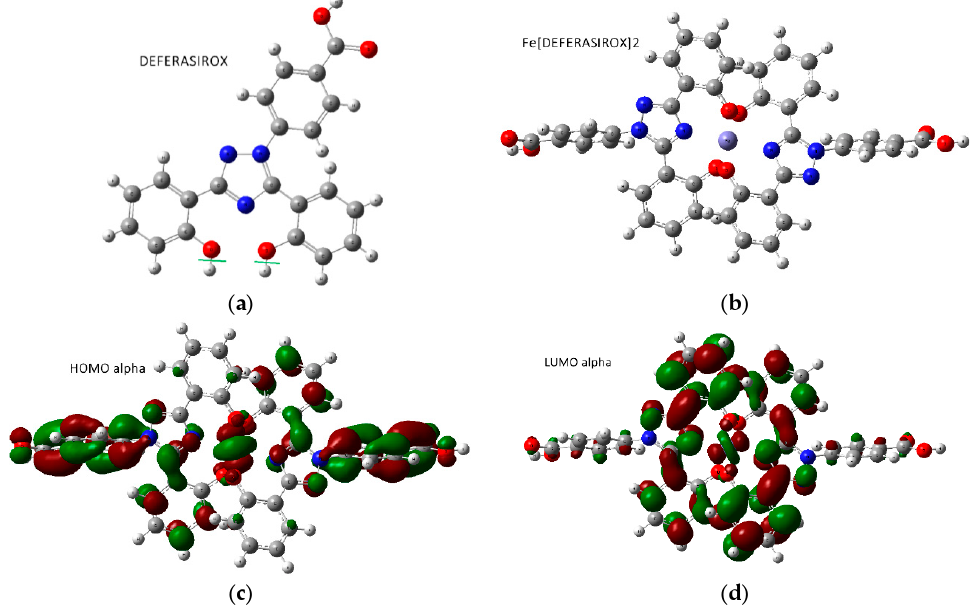
Figure 1. Deferasirox as an iron chelator for therapeutic applications. ( a ) Single molecule with the chelating centers created by removing two hydroxyl H as shown with green lines; ( b ) two molecules needed to chelate the iron(III) ion (Fe 3+ ) within an octahedral coordination; ( c , d ) frontier molecular orbitals (FMOs)—highest occupied molecular orbitals (HOMOs) and lowest unoccupied molecular orbitals (LUMOs)—obtained with quantum chemical calculations at the 6-31g/UB3LYP level (U stands for unrestricted needed when a paramagnetic ion such as Fe 3+ 3 d 5 -or Cu 2+ 3 d 9 hereafter- is involved; cf. text). Δ E(HOMO − LUMO) ≈ 0.26 eV.